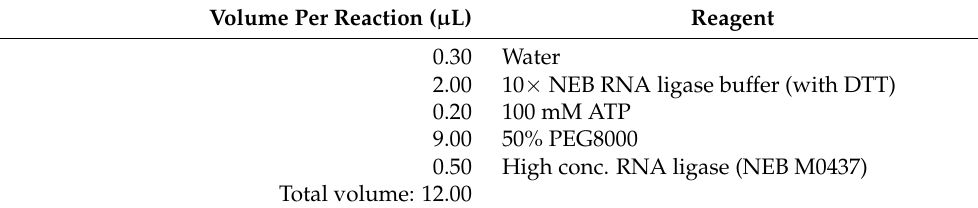
Table 9. Ligation Mix for Second Linker Ligation (3’ End of cDNA).